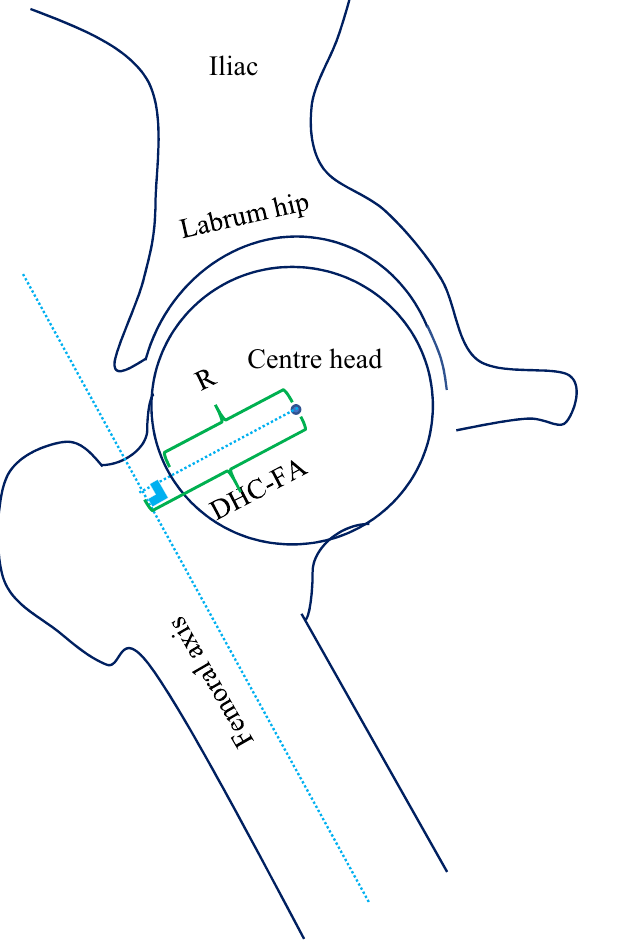
Figure 2. The hip geometry was measured on the lateral view. R radius of the femoral head, D HC-FA distance from the hip center to the femoral